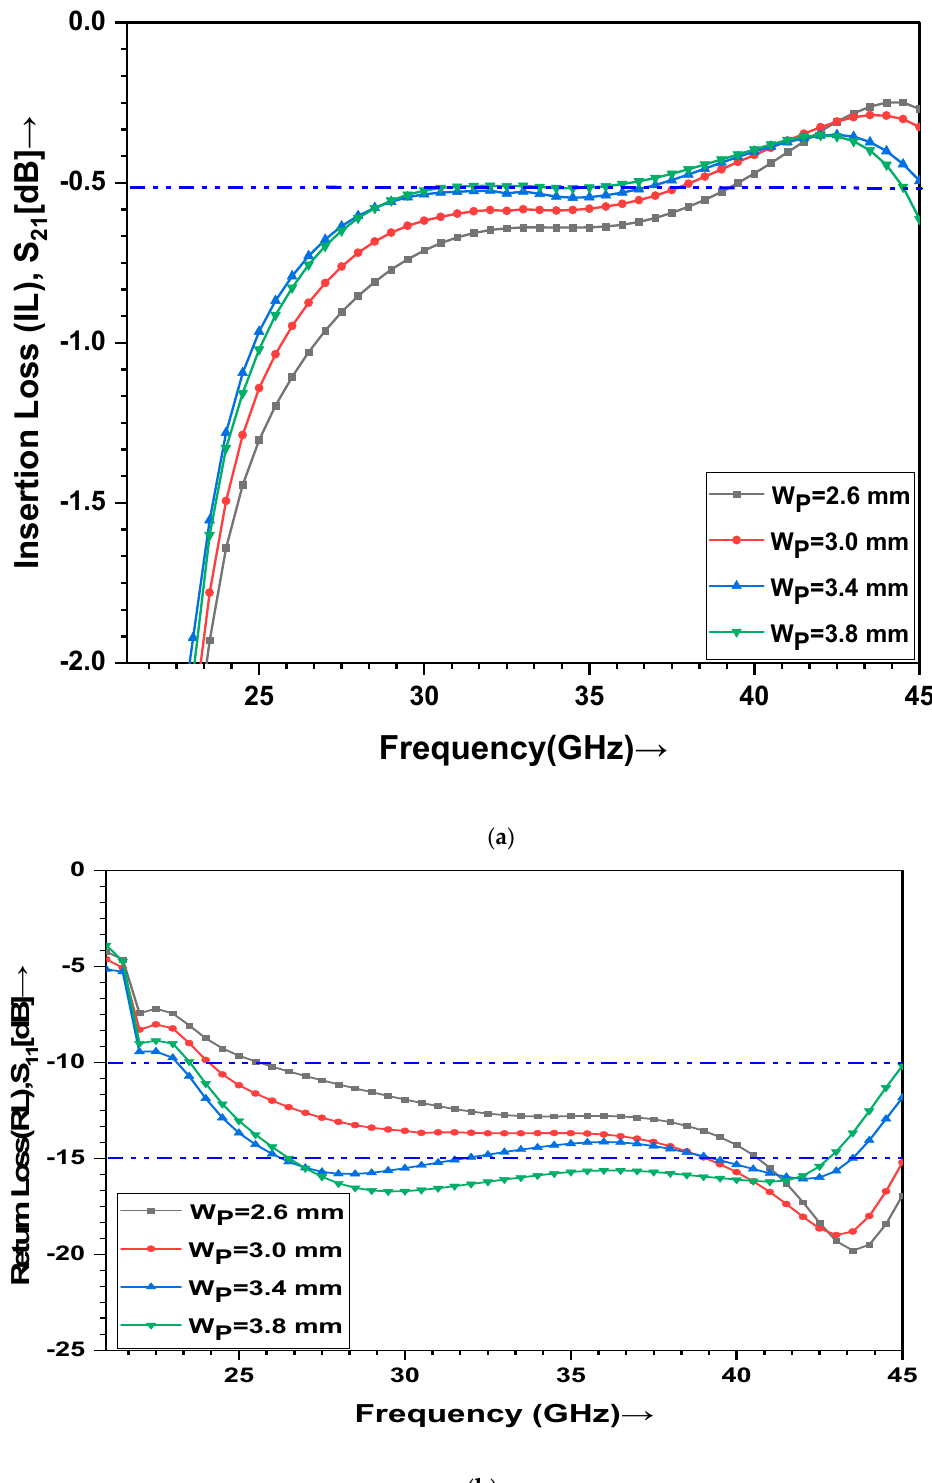
Figure 8. Effect of fish-tail width on ( a ) insertion loss, S 12 (dB) and ( b ) return loss, S 11 (dB).